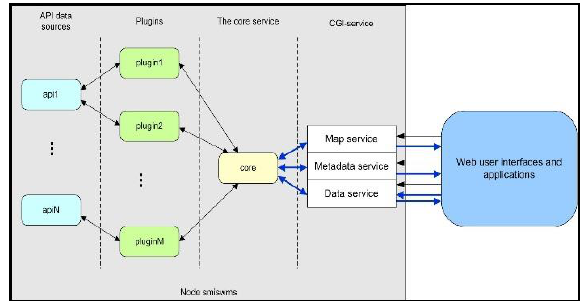
Figure 3. Structure of Application level functional